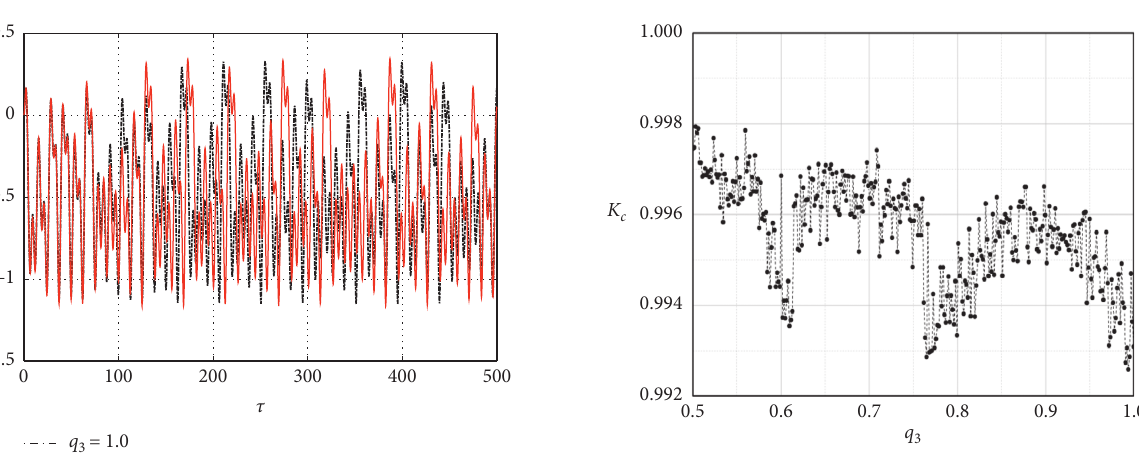
Figure 16: Representation of Kc (0-1 test) vs. 0 . 5 ≤ q tional